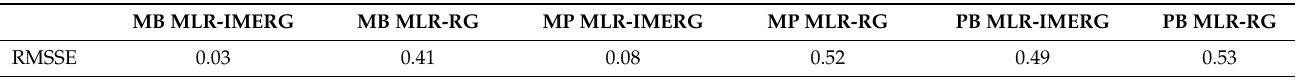
Table 6. Value of the root mean square error standardized (RMSSE) calculated on a monthly basis for Monte Bove Sud (MB), Monte Prata (MP) and Pintura di Bolognola (PB), calculated through interpolation (MLR), IMERG data to which was added the real snowfall data (IMERG) and the data measured by the rain gauge